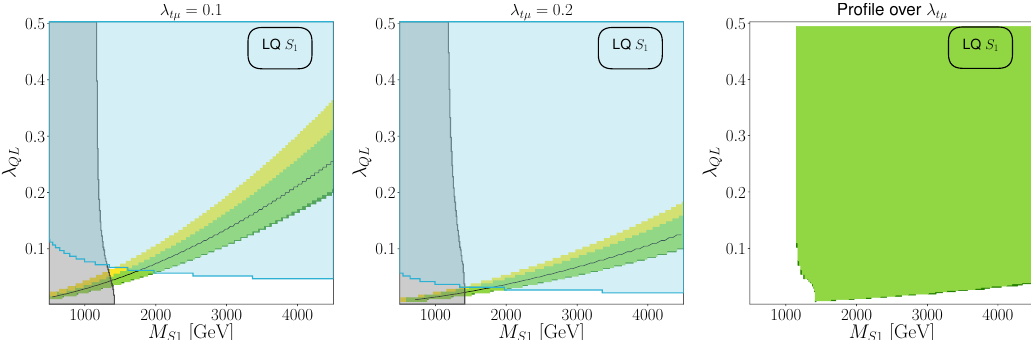
and/or ∆ a 2021 in the model with an SU(2) singlet Figure 2. Scenarios which can explain ∆ a BNL L µ µ scalar leptoquark S defined in eq. (3.4). Results are shown in the M - λ plane for fixed λ = 0 . 1 1 S 1 QL tµ (left panel), λ = 0 . 2 (middle panel) and by varying λ [0 , 0 . 5] (right panel). In the latter case tµ tµ ∈ we profile to find the regions in the M - λ plane that for some value of λ in the scan, satisfy S 1 QL tµ all experimental constraints and can explain the ∆ a measurements within 1 σ . Regions which µ can explain ∆ a BNL and ∆ a 2021 to within 1 σ are yellow and green respectively, with the overlap µ µ between these two regions coloured lime. The black line indicates points which produce a ∆ a µ contribution matching eq. (1.7). The grey regions are excluded by scalar leptoquark searches at the Large Hadron Collider [440]. Regions shaded cyan are disfavoured as they provide a relative contribution which shift the muon mass up by more than 100% or down by more than 50% as in eq. (3.8). In the right panel only solutions which have not been excluded by leptoquark searches or Z → µµ or Z → νν constraints are displayed, i.e. any points ruled out by any of these experimental constraints are